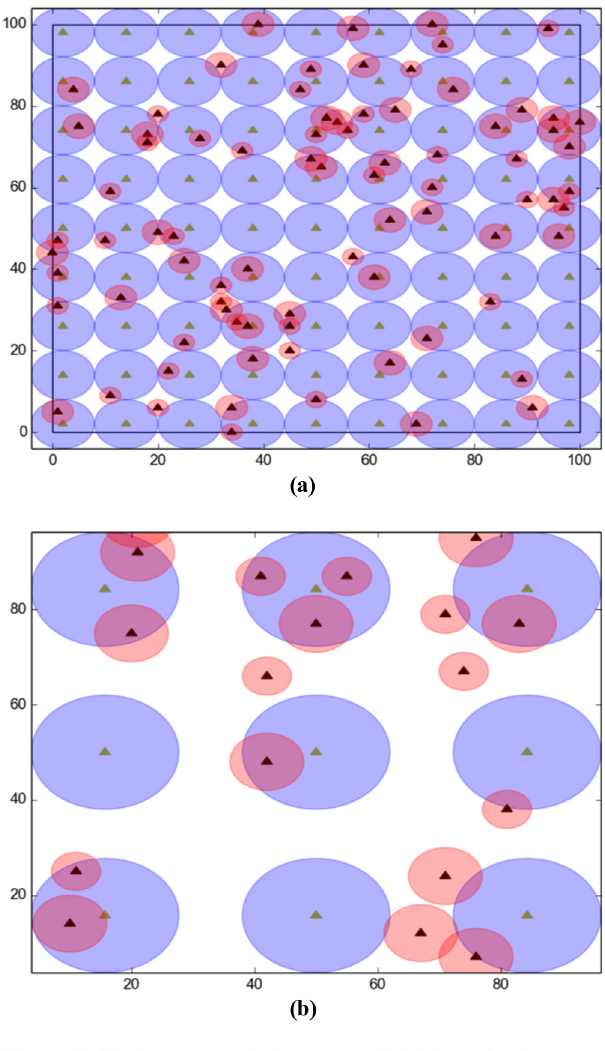
Figure 7. Static